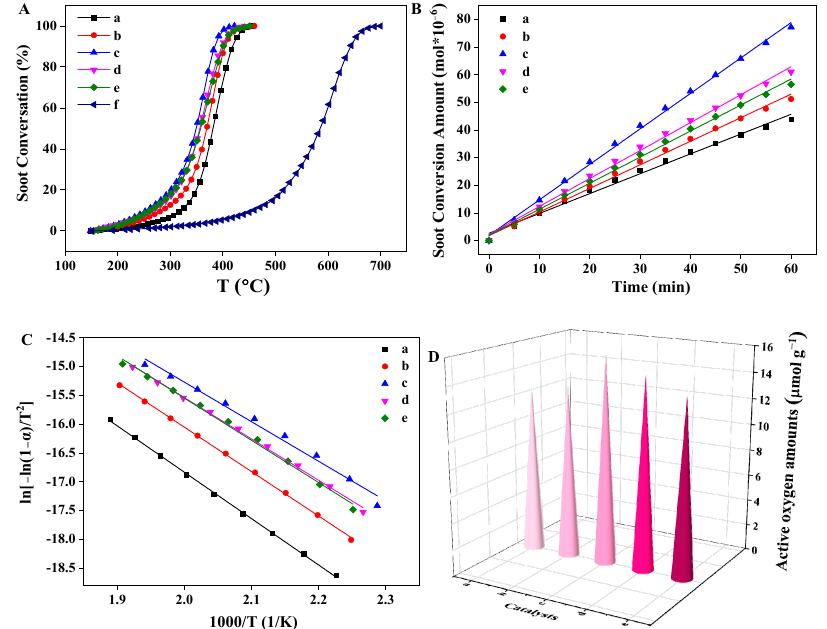
Figure 8. Catalytic performances for soot-conversion percentage ( A ), soot-conversion amount as a function of time ( B ), Arrhenius plots ( C ), and active oxygen amount ( D ) over Pt n /Ni 1.5 Co 0.5 AlO catalysts: (a) Ni 1.5 Co 0.5 AlO; (b) Pt 1 /Ni 1.5 Co 0.5 AlO; (c) Pt 2 /Ni 1.5 Co 0.5 AlO; (d) Pt 4 /Ni 1.5 Co 0.5 AlO; (e) Pt 6 /Ni 1.5 Co 0.5 AlO; (f) no catalyst. Table 1. Catalytic activities, densities of active oxygen, relative reaction rates (R), and TOF values of Pt n /Ni 1.5 Co 0.5 AlO catalysts for soot combustion under conditions of loose contact.